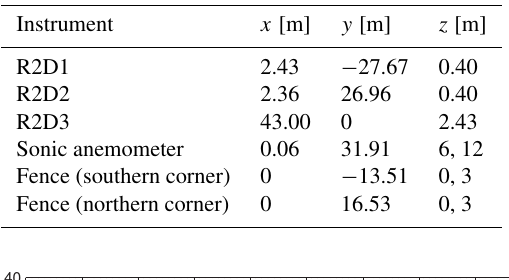
Table 1. Instrumentation coordinates for the fence experiment. Instrument